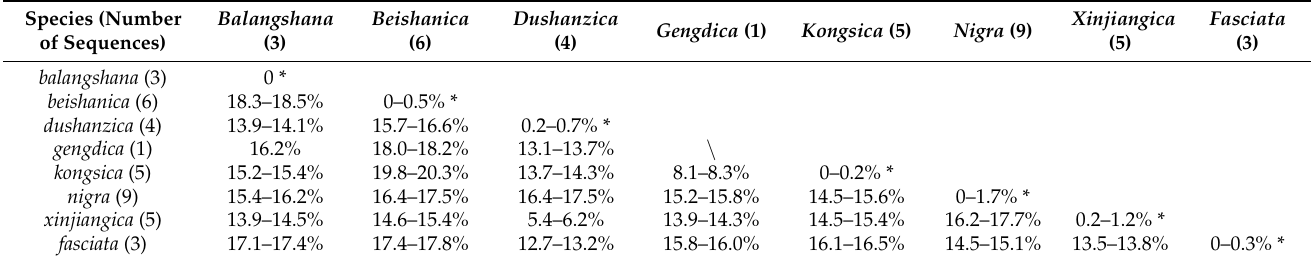
Table 2. Genetic distances between Blepharicera Macquart, 1843 COI